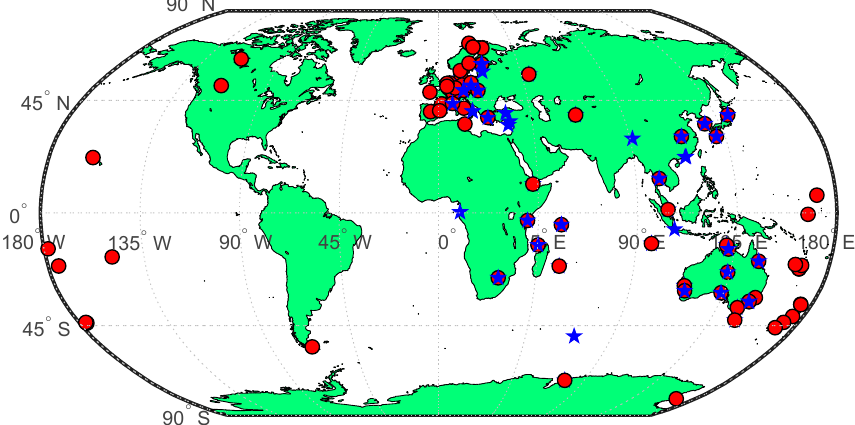
Figure 5. Observation networks in the POD of satellite C07 on Oct 16 (red circle) and C02 on 19 October (blue star).